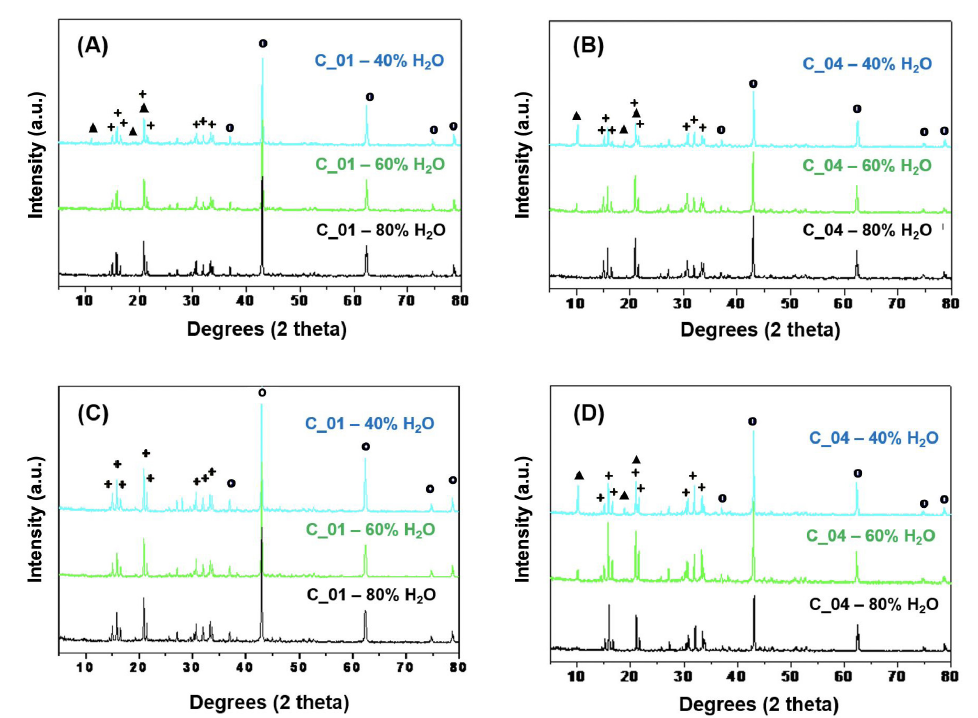
Figure 4. X-ray diffractograms of compositions C_01 and C_04 prepared from MgO powders calcined at (A and B) 900 ºC / 2 h and (C and D) 1100 ºC / 2 h, respectively, with different water contents. (Phases: + struvite; ▲ dittmarite; ○